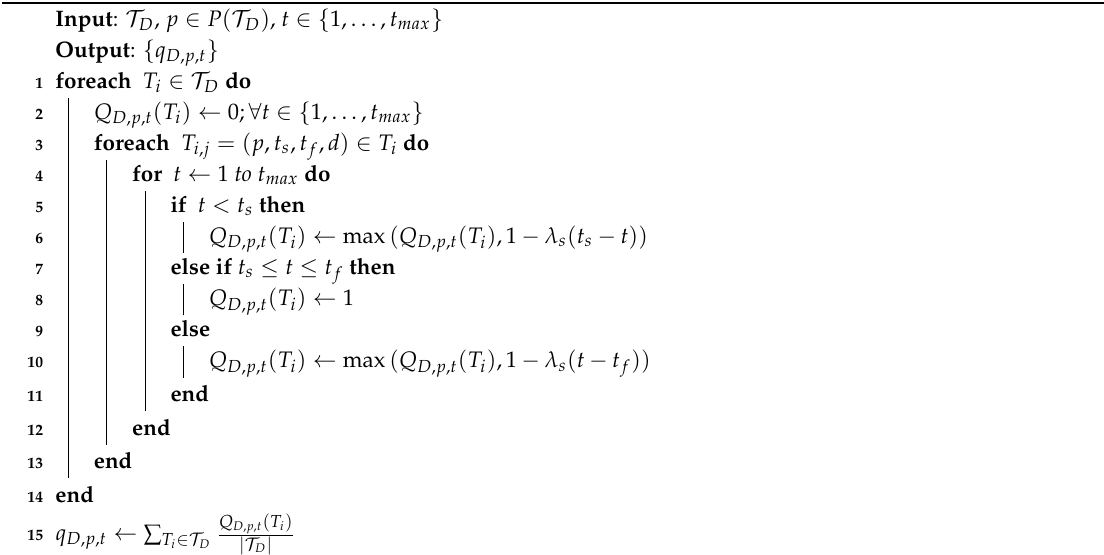
Algorithm 1: Algorithm for Calculating the Probability of a